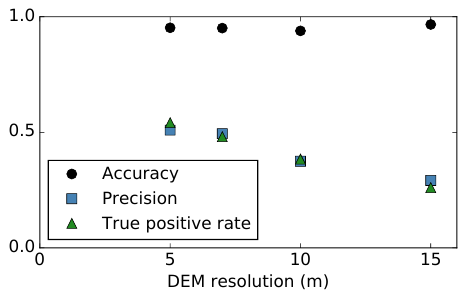
Figure 8. Method performance as a function of input DEM resolu- tion.